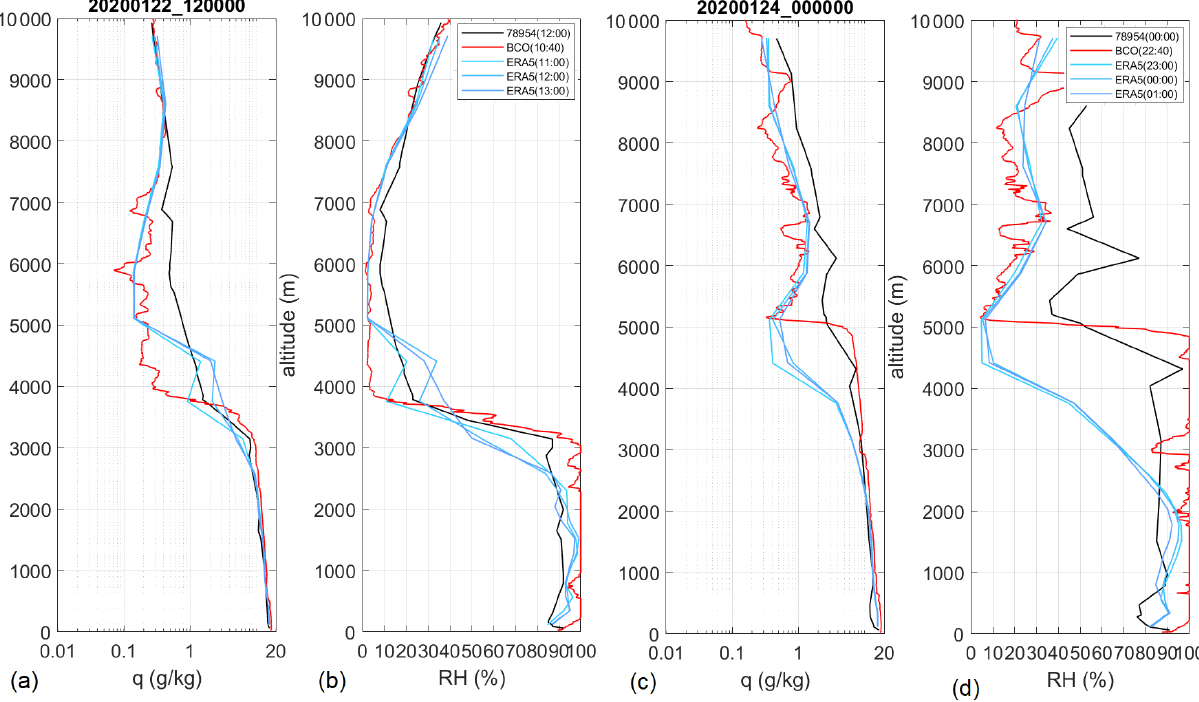
Figure 7. Humidity profiles from BCO and Grantley Adams radiosondes (WMO ID 78954) on (a, b) 22 January 2020 at 12:00UTC and (c, d) 24 January 2020 at 00:00UTC (exact times are indicated in the plot legend). Table 5. Pairwise comparison of IWV estimates from GNSS station BCON (GPS), HATPRO MWR, Vaisala RS41 radiosondes released from the BCO (RS BCO), operational radiosondes released from Grantley Adams International Airport (RS GA), and ERA5 reanalysis. The HATPRO data set has been separated in two parts: before and after 27 January when the system was fixed for an instrumental failure. For each period, the data from all sources have been time matched. Comparison Mean diff. SD diff. Slope Offset R